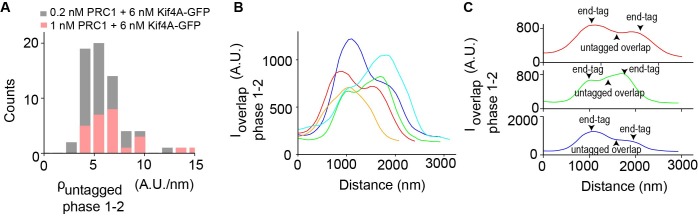
Protein density at phase 1–2 transition in microtubule overlaps.(A) Histogram of the untagged density ρuntagged, in the microtubule overlap at phase 1-2 transition. Assay conditions: (i) 0.2 nM PRC1 + 6 nM Kif4A-GFP (black; mean: 5 A.U./nm; N = 64) and (ii) 1 nM PRC1 + 6 nM Kif4A-GFP (red; mean: 7 A.U./nm; N = 26). (B) Line scan analysis of the Kif4A intensity from five kymographs which show the distribution of Kif4A within the overlap at the phase 1–2 transition. (C) Zoomed-in view of three events in (B) showing end-tag and untagged overlap regions.10.7554/eLife.32595.014Figure 4—figure supplement 4—source data 3.This spreadsheet contains untagged density ρuntagged, in the microtubule overlap at phase 1-2 transition used to generate the histogram in Figure 4—figure supplement 4A.